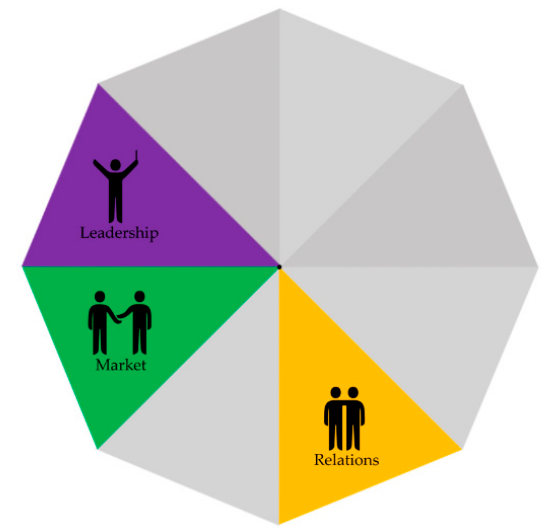
Figure 2. Creating a feeling of equivalence.